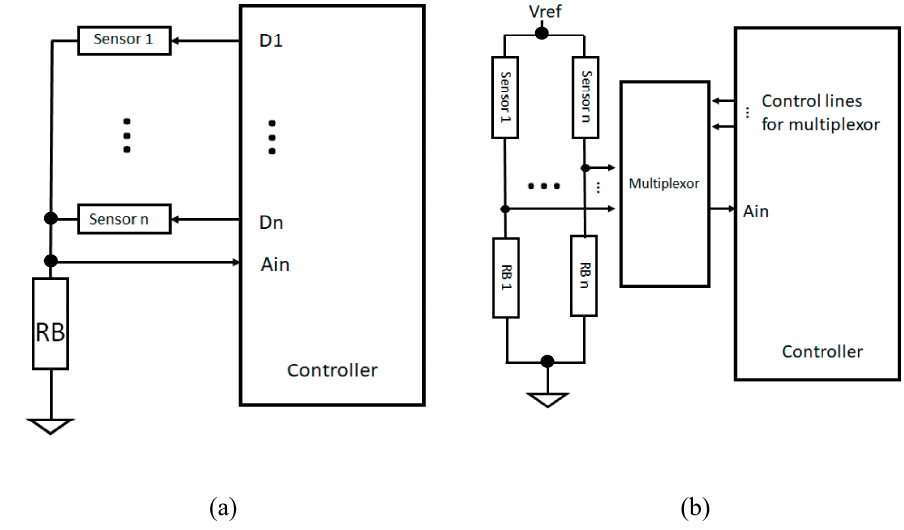
Figure 5. Examples of line scanning circuitries. ( a ) Configuration 1; ( b ) Configuration 2.